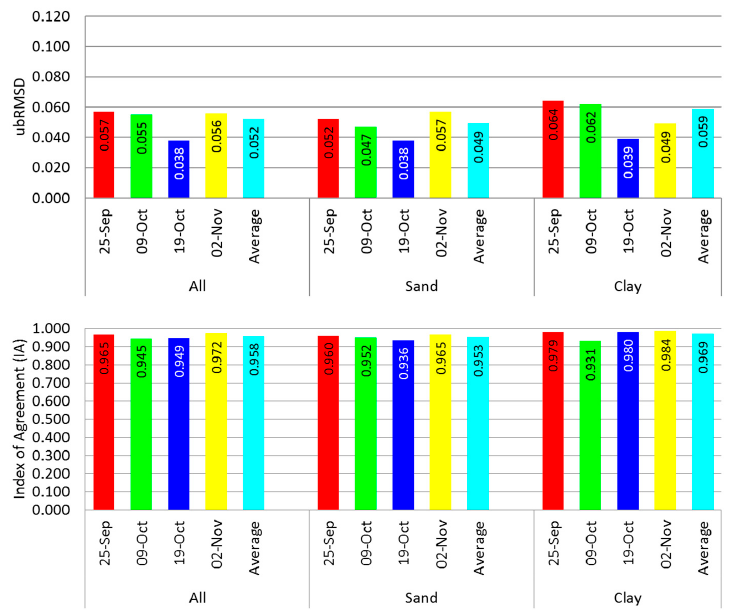
Figure 8. Statistical validation indices for the analysis of soil moisture obtained by the SVS and the SAR imagery.